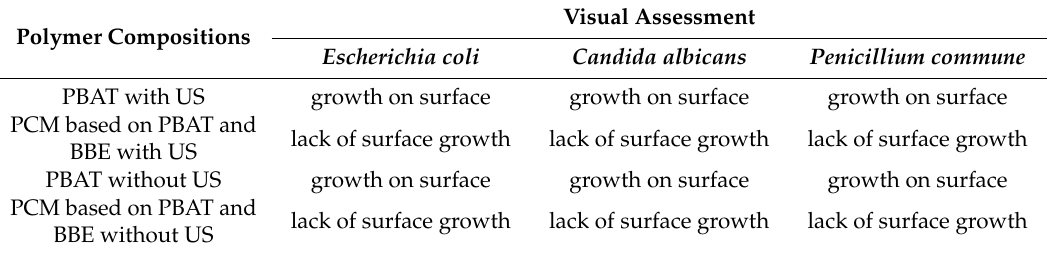
Table 6. Results of visual assessment of the surface of polymer compositions, inoculated within 24–48